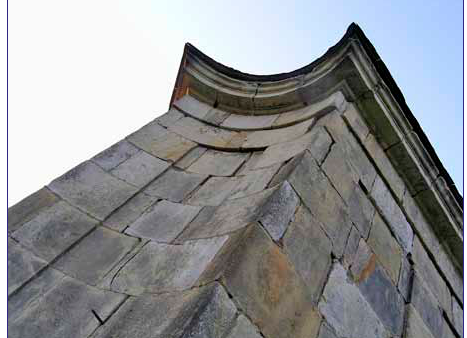
fig. 5. Mikulašovice. Holy Trinity chapel u pěti lip, Z. Hofmann, 1741–1742. Detail of the corner. Photo: